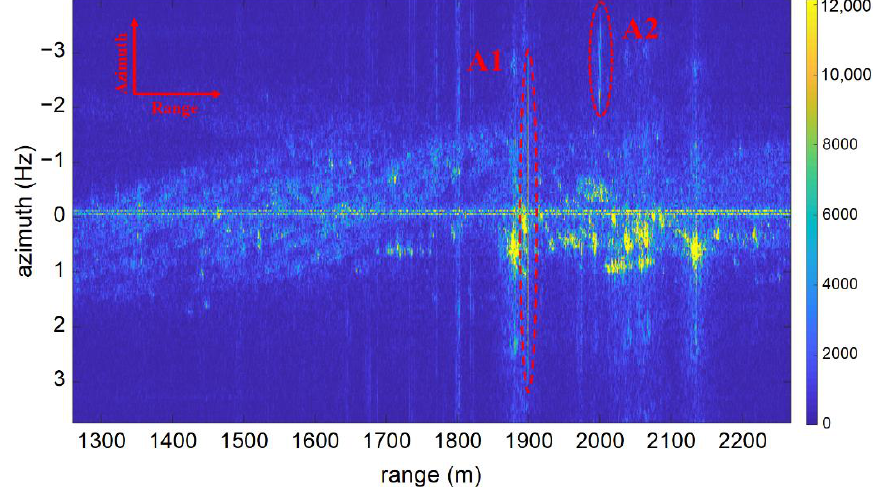
Figure 13. The imaging result of the synthetic data.